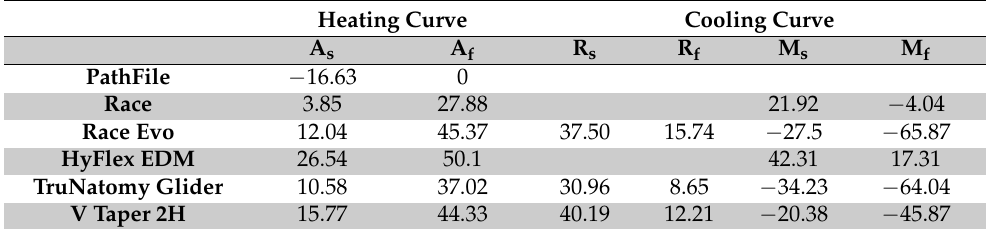
Table 1. Phase transformation temperatures from the DSC